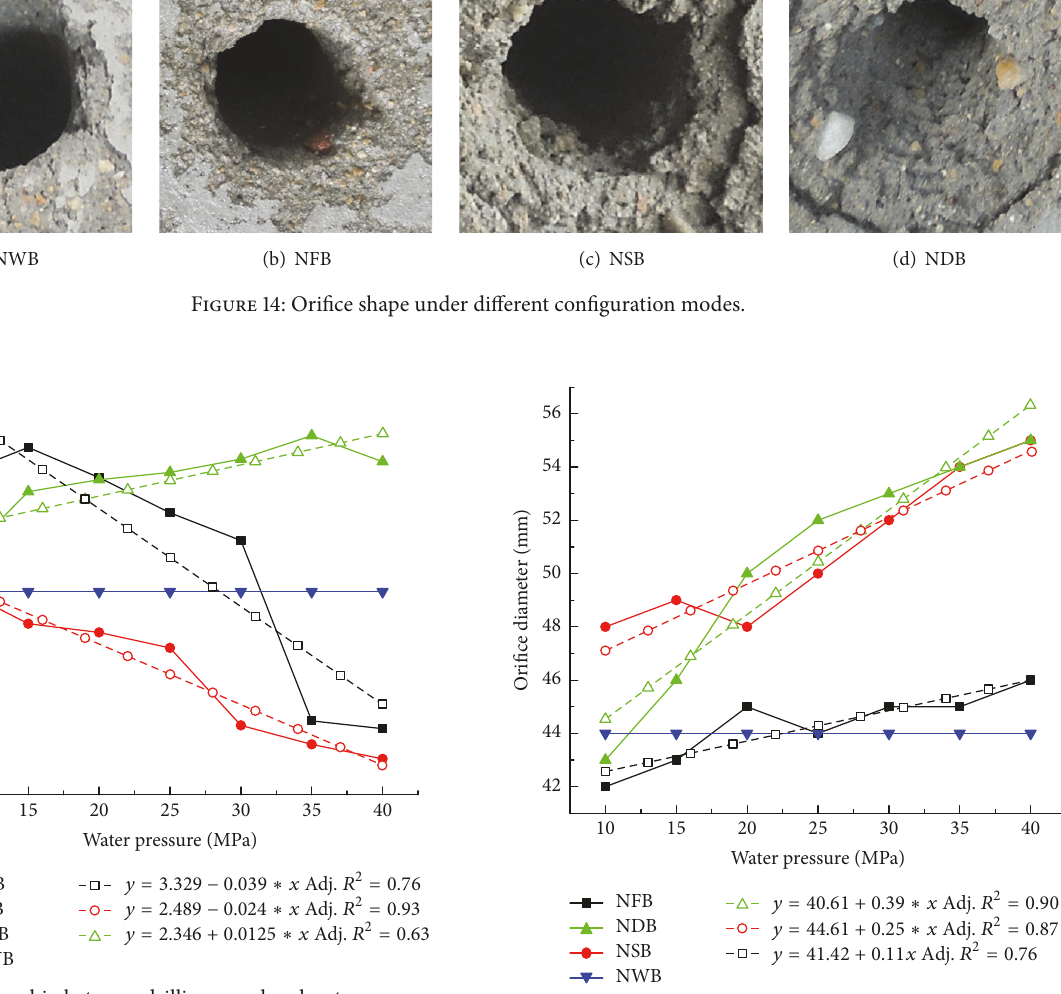
Figure 15: Relationship between drilling speed and water pressure.